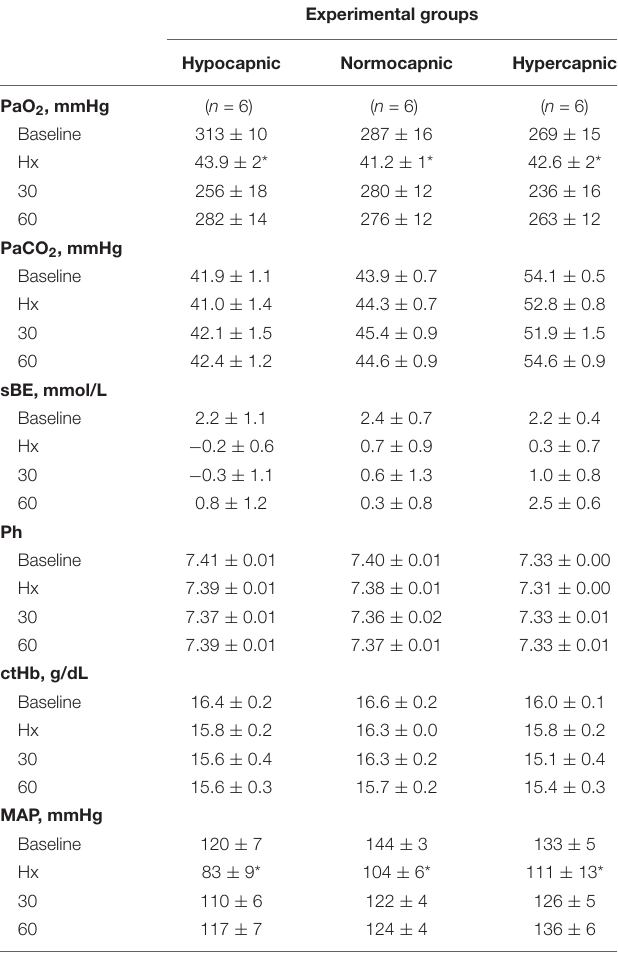
TABLE 1 | Stability of blood samples and mean arterial pressure (MAP) among experimental groups throughout the moderate acute intermittent hypoxia protocol